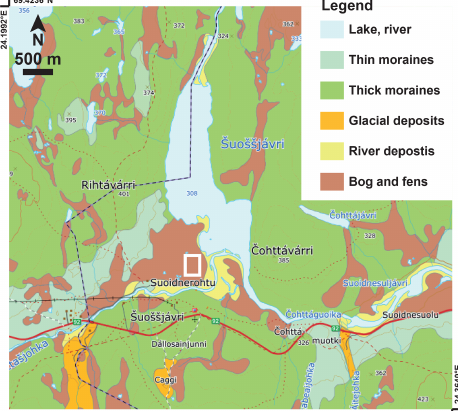
Figure A2. Geomorphological map of the surroundings of the study site. The white rectangle indicates the study site. Source: Geological Survey of Norway